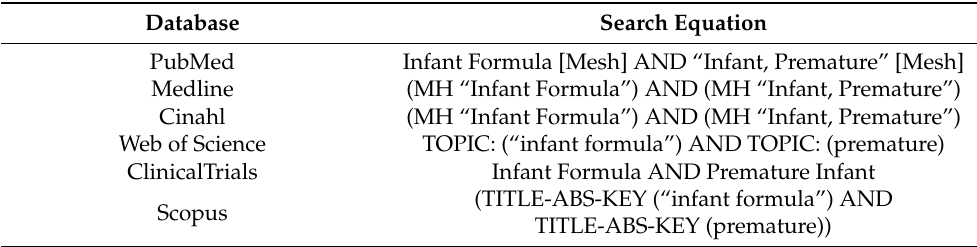
Table 1. Search strategy according to the focused question